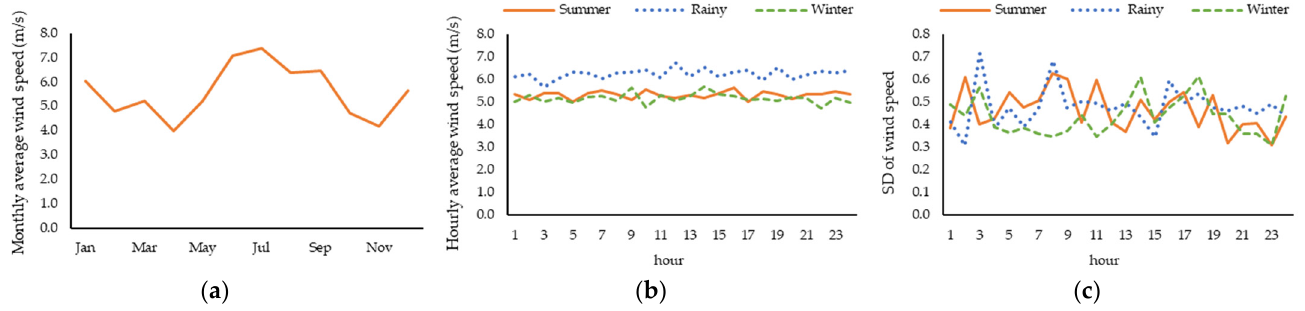
Figure 19. Wind data consist of: ( a ) monthly average wind speed; ( b ) hourly average wind speed and; ( c ) standard deviation of hourly wind speed for the summer, rainy, and winter season.